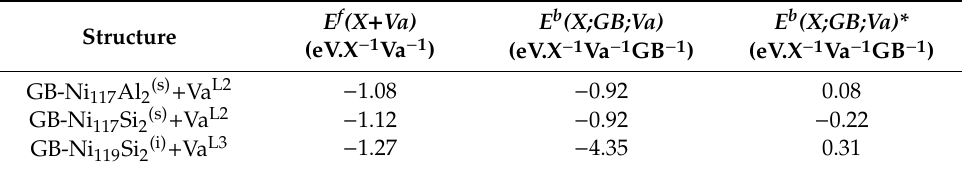
Table 9. The formation energy of the vacancy-impurity couple defect at GB ( E f (X + Va) ), the binding energy of the triple defect with respect to the total energy of three single defects (GB, X, Va) ( E b (X;GB;Va) ) and the binding energy of triple defect with respect to the total energy of three couple defects (GB + X, X + Va, Va + GB) ( E b (X;GB;Va)* ) for GB-Ni 117 Al 2(s) + Va L2 , GB-Ni 117 Si 2(s) + Va L2 and GB-Ni 119 Si 2(i) + Va L3 structure. E f (X + Va) E b (X;GB;Va) E b (X;GB;Va)* Structure (eV.X − 1 Va − 1 ) (eV.X − 1 Va − 1 GB − 1 ) (eV.X − 1 Va − 1 GB − 1 ) GB-Ni 117 Al 2(s) + Va L2 − 1.08 − 0.92 0.08 GB-Ni 117 Si 2(s) + Va L2 − 1.12 − 0.92 − 0.22 GB-Ni 119 Si 2(i) + Va L3 − 1.27 − 4.35